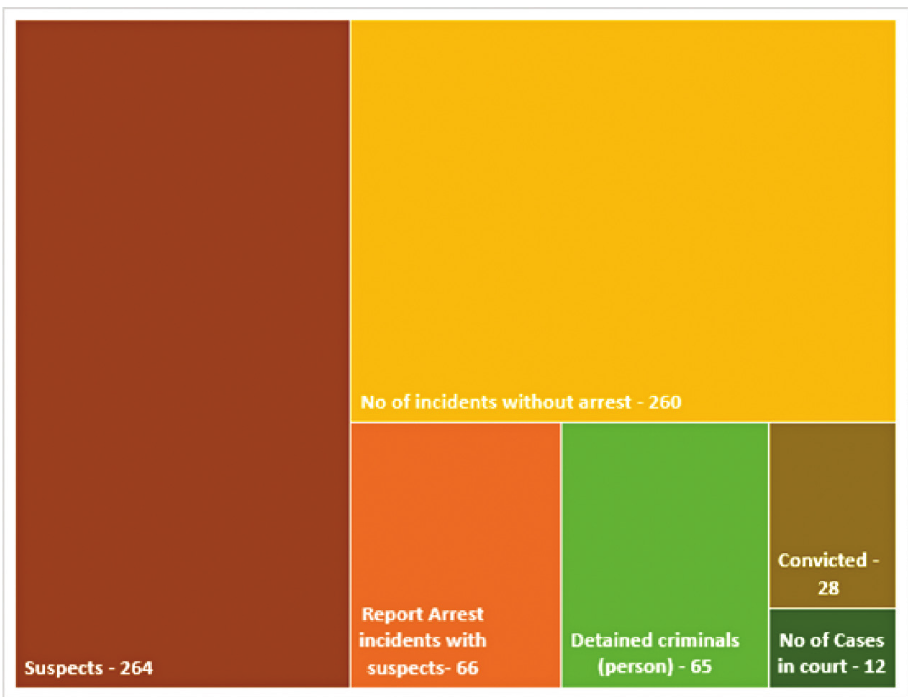
Figure 5. Proportion of arrest made with criminal suspects and convicted cases reported for pangolin confiscation.